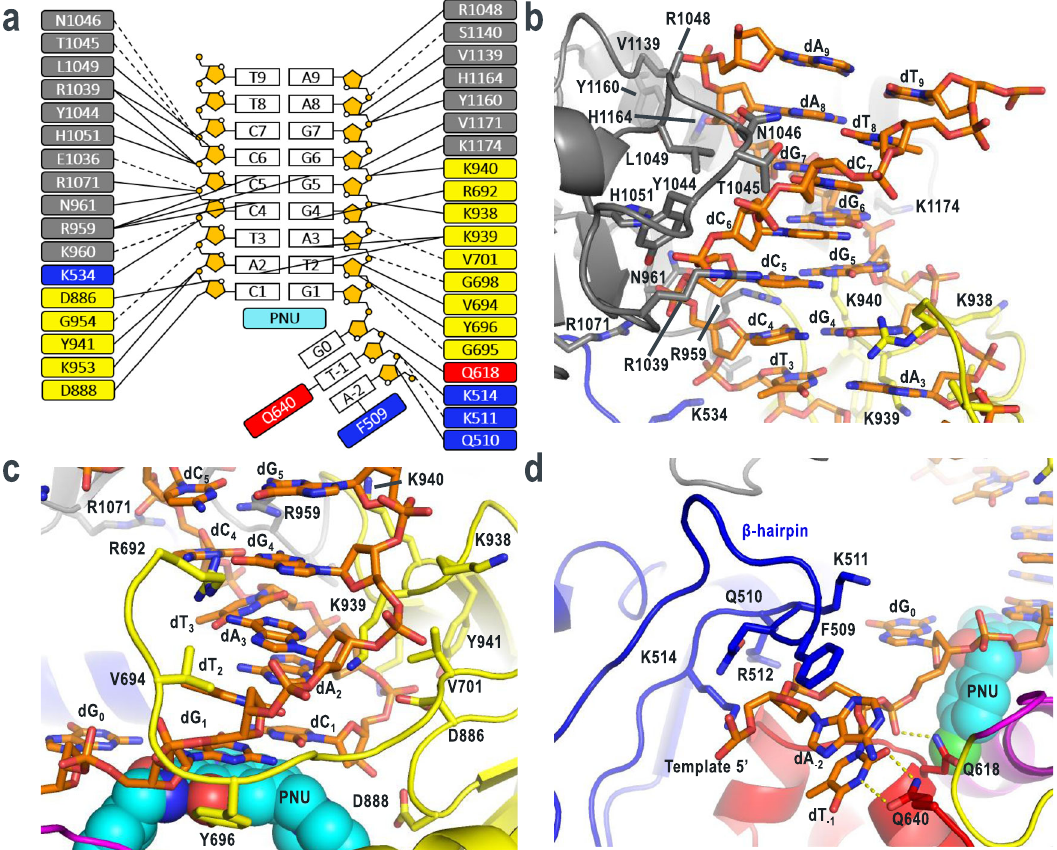
Fig. 3 HSV1 pol — DNA contacts. a Schematic of protein — DNA interactions. Solid lines represent side chain interactions with DNA. Dashed lines represent main chain interactions with DNA. b Detailed view highlighting thumb domain interactions with the primer-template minor groove. c Detailed view of interactions between the palm domain and DNA. d Exonuclease β -hairpin and N-terminal domain interactions with the 5 ′ single-stranded template. Hydrogen bonds are shown as yellow